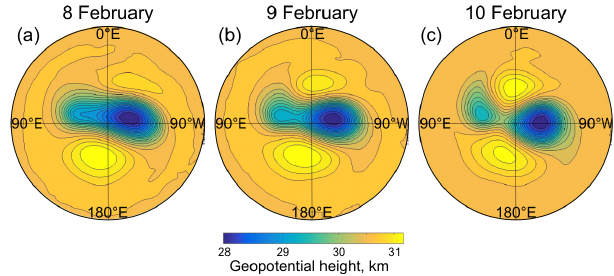
Figure 1. The polar vortex split at the 10hPa pressure level during the SSW event in February 2018. Geopotential heights are calcu- lated from ERA-Interim reanalysis